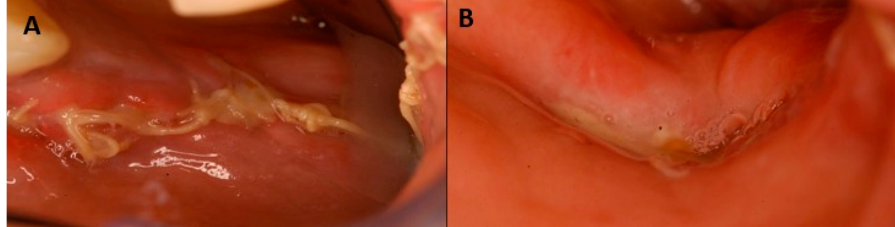
Figure 12. ( A ) Surgical site after 7 days; ( B ) Complete healing after 14 days since surgery.